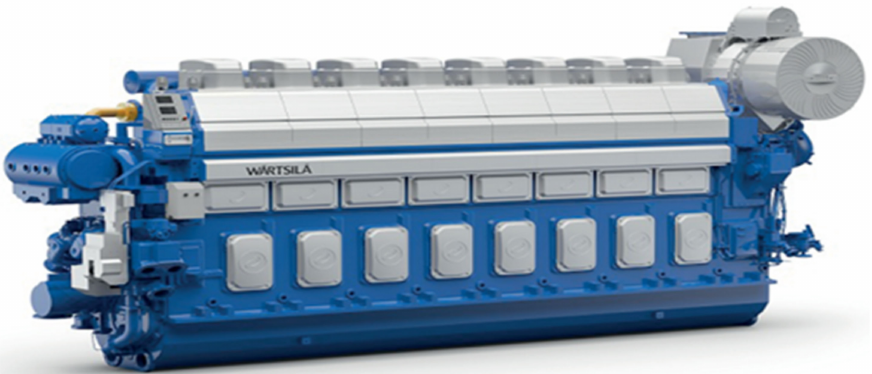
Figure 9. Main Wartsila propulsive